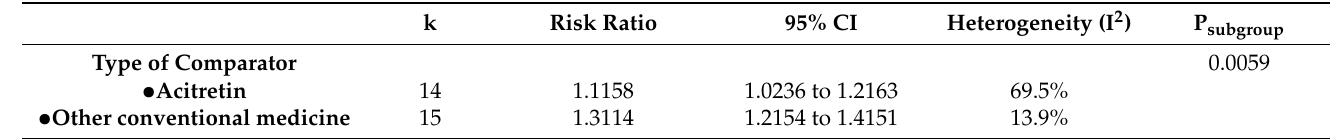
Figure 8. Bubble plot of PASI 60 for type of comparator. Table 3. Subgroup analysis of the trials that compared EAHM with CM for PASI 60.